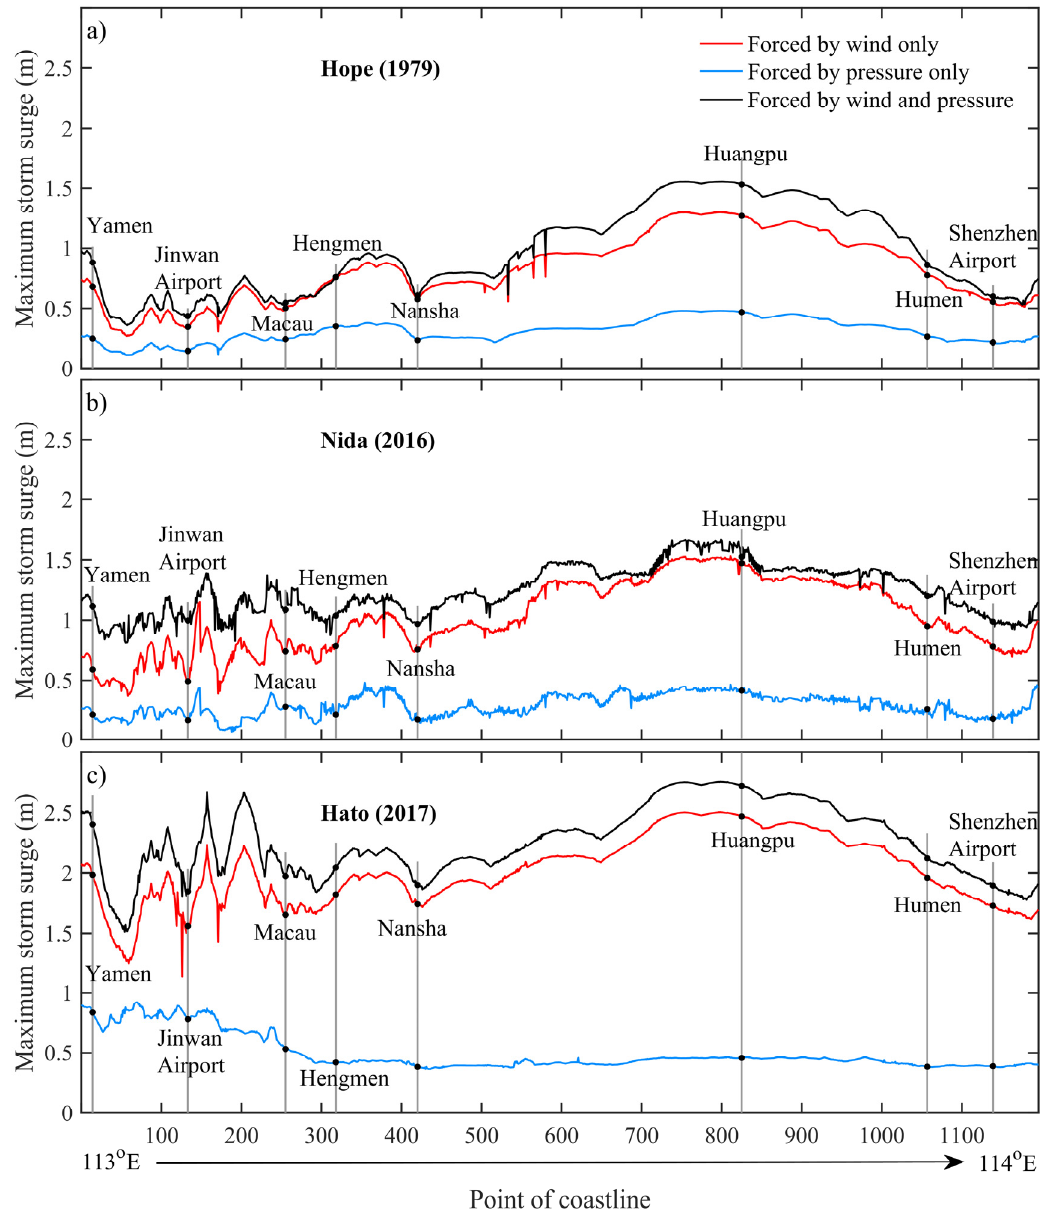
Figure 6. Curves of simulated maximum storm surges (units: m) generated by different forcing fields along the PRE coast. ( a – c ) The range of points shown in ( a – c ) corresponds to the coastline from 113 ◦ E to 114 ◦ E in the Figure 4b. The blue curves present the maximum storm surge of the pressure forcing, the red curves present the maximum storm surge of the wind forcing, and the black curves present the maximum storm surge of the wind-pressure forcing. Some famous stations of the coastal area are marked in sub figures to show their storm surges.